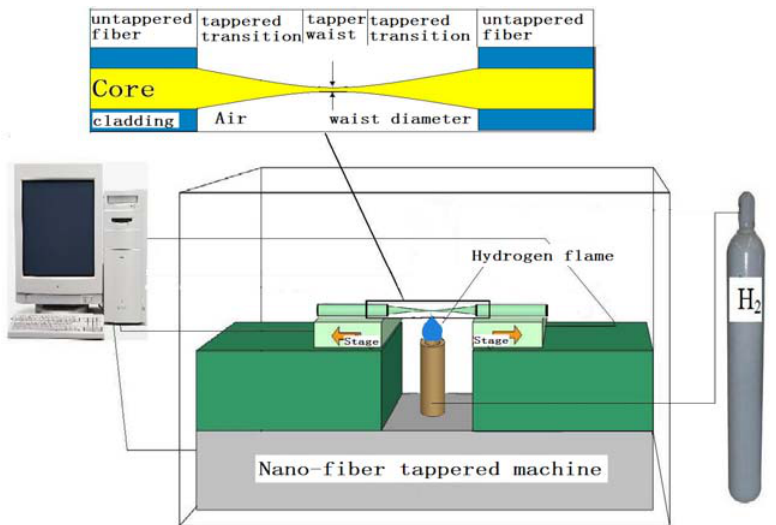
Figure 2. Schematic of fiber tapering.